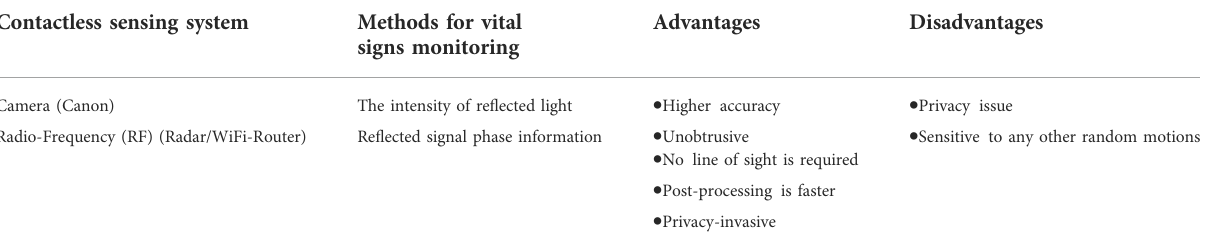
TABLE 1 A comparison of Camera and Radar System for Vital Signs